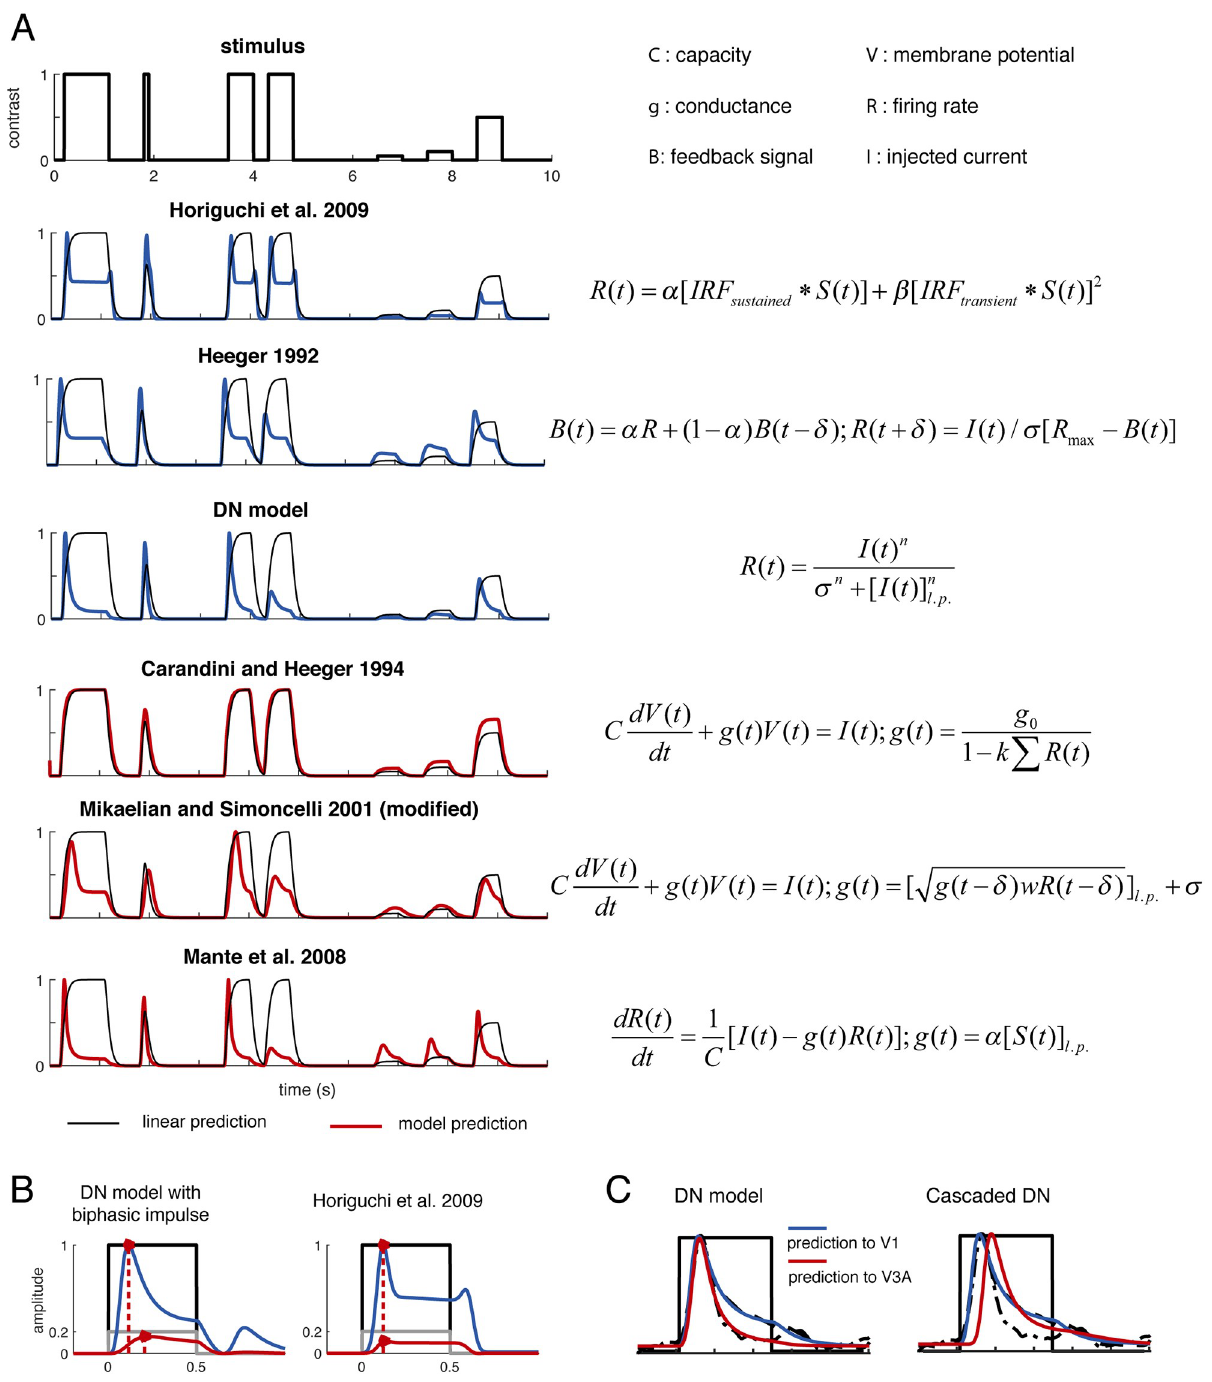
Fig 7. Comparison between temporal models. A. We compared two groups of models by simulating their outputs to a set of stimulus time courses (different stimulus durations, ISIs, and different stimulus contrasts). One group of models (red) is inspired by RC-circuit models of normalization, and assumes gain control is implemented by changes in membrane conductance associated with spiking. The other group of models (blue) do not make this assumption. Within each set, there are some (but not all) models that capture the properties of the response time courses summarized in Fig 1. B. The two temporal channels model does not assume a gain control component. As a consequence, when stimuli are of lower contrast, the model captures the reduced response amplitude but not the slower dynamics. Within a model group, if the level of gain control depends on the instantaneous instead of the history-dependent response, the model does not reproduce the transient-decay response shape. C . The difference between the response time course from a striate versus an extra-striate visual area (earlier response peak and higher response level at stimulus offset for the striate response) can also be qualitatively captured by cascading the DN model: the first layer takes the stimulus time course as input, and the second layer takes the response output from the first layer as input.